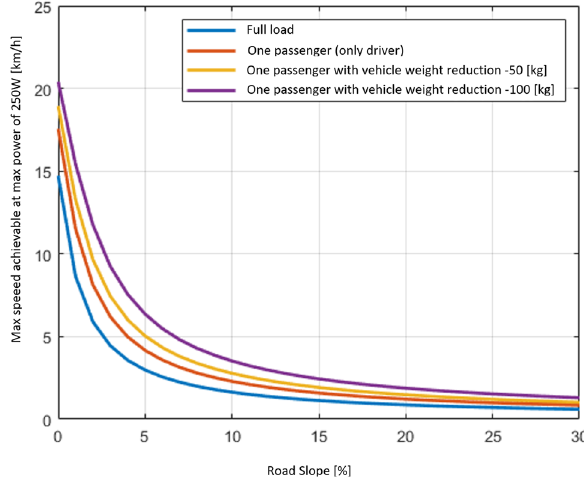
Fig. 20 Maximum achievable speed as a function of road